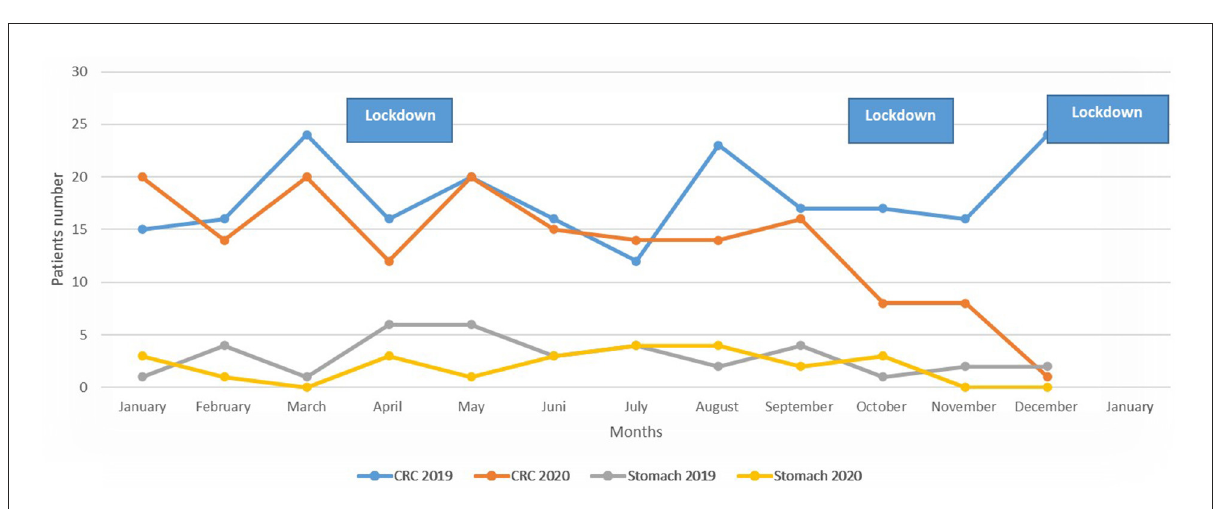
FIGURE2 Frequency of diagnosis of CRC and GC according to